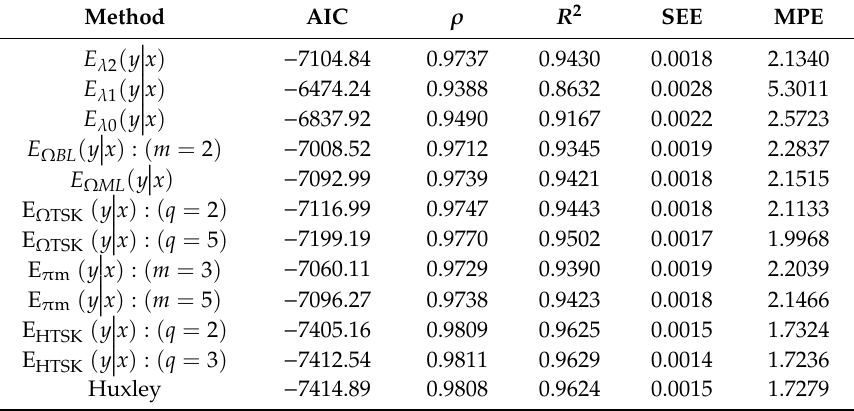
(cid:12) (cid:12) E Ω BL ( y (cid:12) x ) : ( m = 2 ) −